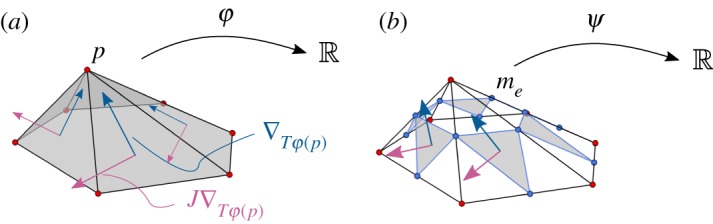
Examples of a function φ ∈ Sh together with ∇φ, J∇φ (a) and ψ ∈ Sh* with ∇ψ, and J∇ψ (b) defined over the triangle T.